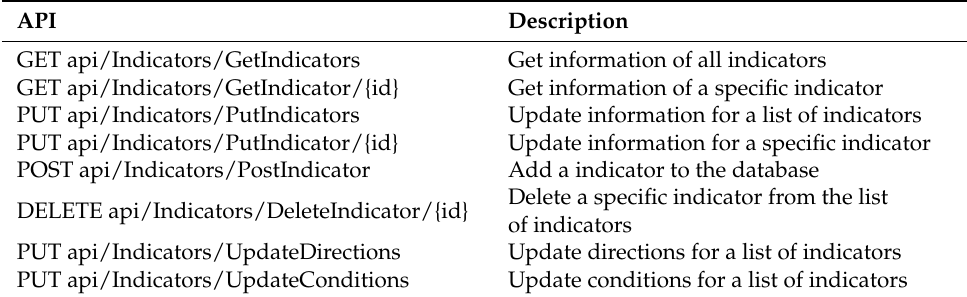
Table 1. Description of Indicators